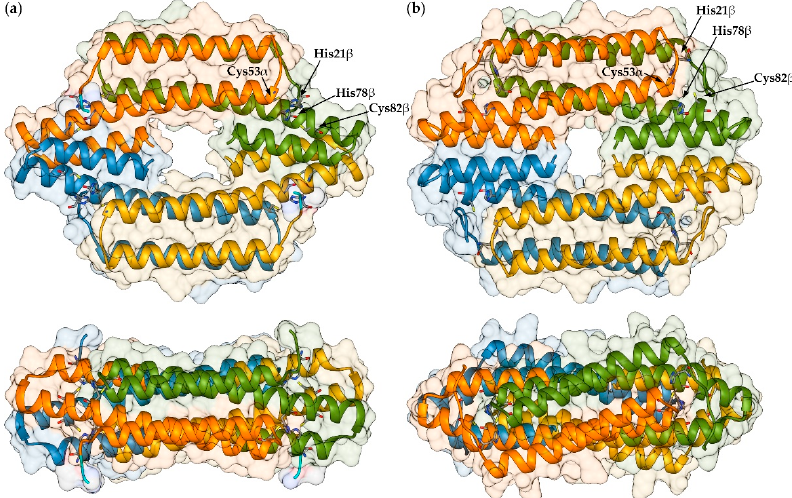
Figure 3. Ribbon diagram and molecular surface of apo- Sy InrS ( a ) and holo- Sy InrS ( b ). Chains α , β , α ’, and β ’ are coloured as in Figure 1. In panel ( a ), the reconstructed residues of chains α and α ’ are in red. Proposed Ni(II) binding residues are reported as sticks coloured accordingly to the atom type. The orientations in the bottom panels are rotated by 90 ◦ around the horizontal axis with respect to the orientations in the top